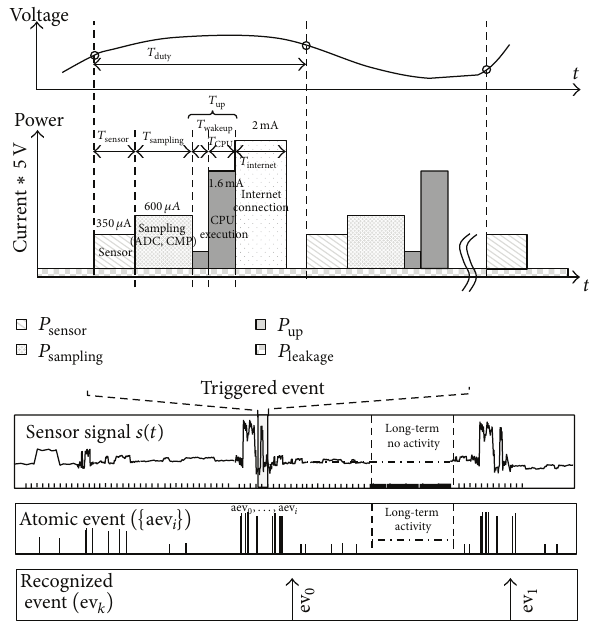
Figure 1: Power consumption for sensor signal sampling and processing in long-term activity